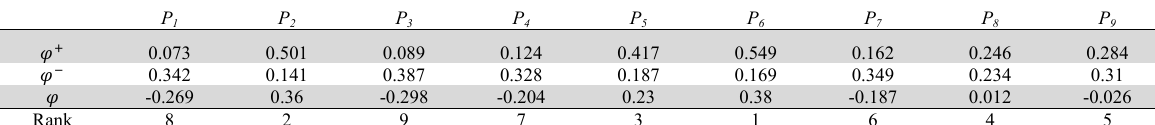
Project ranking using the Promethee II